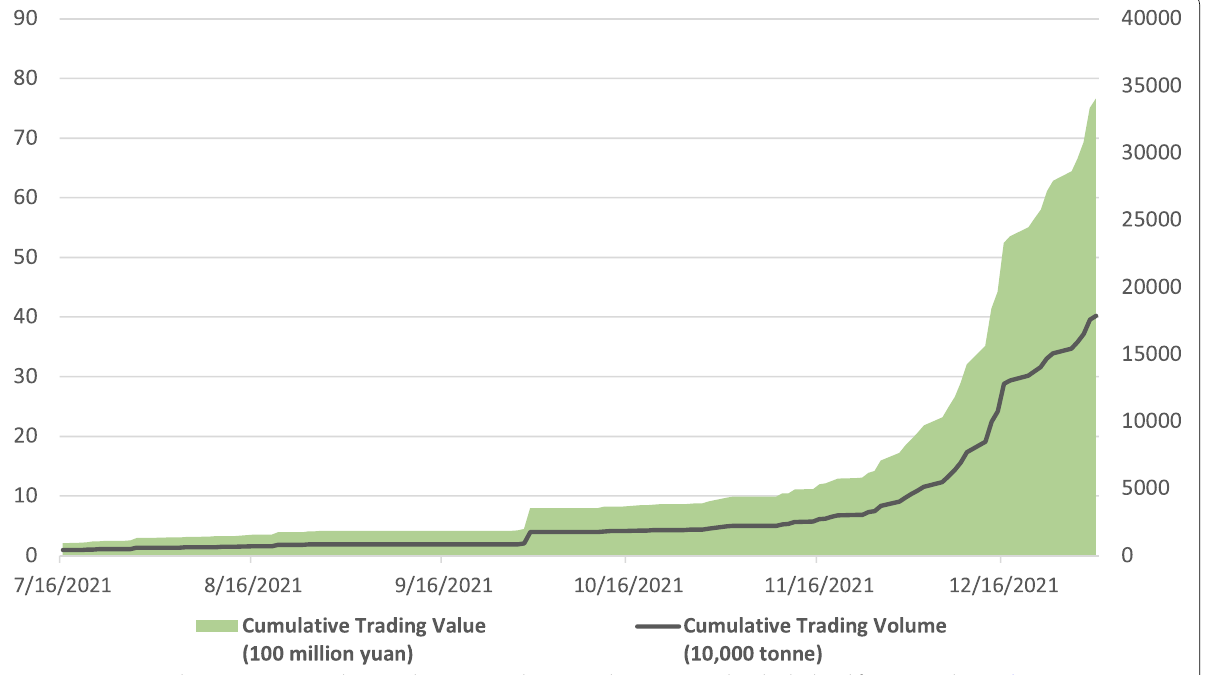
Fig. 1 CEA’s Accumulative Transaction Volume and Turnover in the National ETS (Retrieved and calculated from open data on https:// www. cneeex.